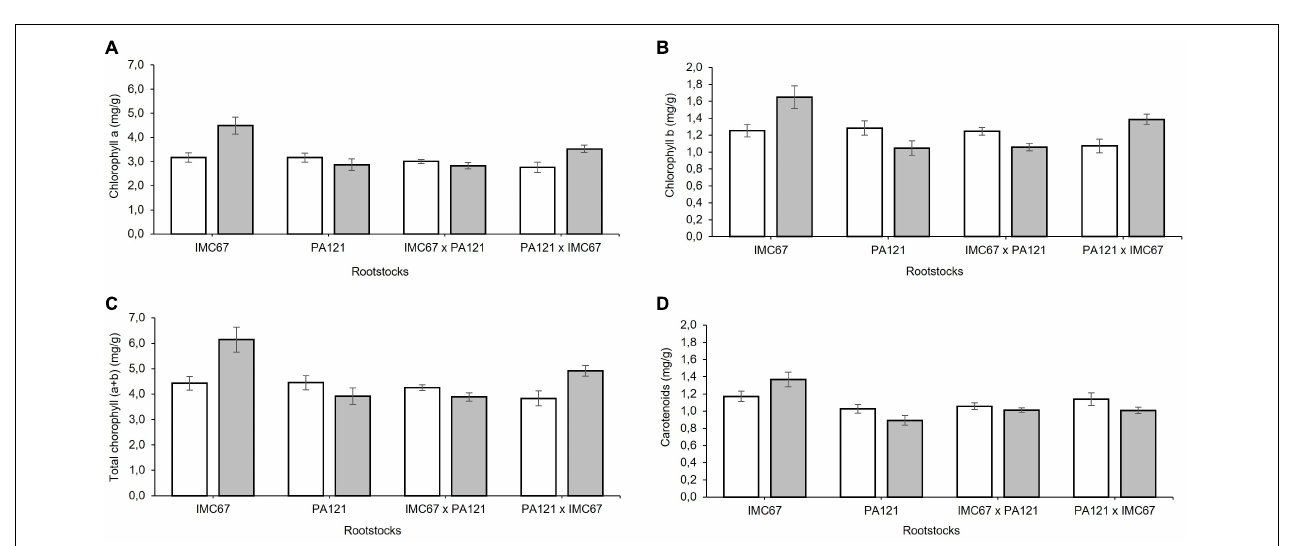
FIGURE 9 | Content of chloroplast pigments of ungrafted seedling families subjected to two different concentrations of Cd in soil under greenhouse conditions 5 months after cadmium addition. (A) Content of chlorophyll a . (B) Content of Chlorophyll b . (C) Content of total Chlorophyll. (D) Content of carotenoids. White bars represent seedling families grown in soil without addition of Cd (0.43 mg kg − 1 ). Gray bars represent seedling progenies grown in Cd spiked soil (7.49 mg kg − 1 ). Data are mean values ± SE ( n = 8).